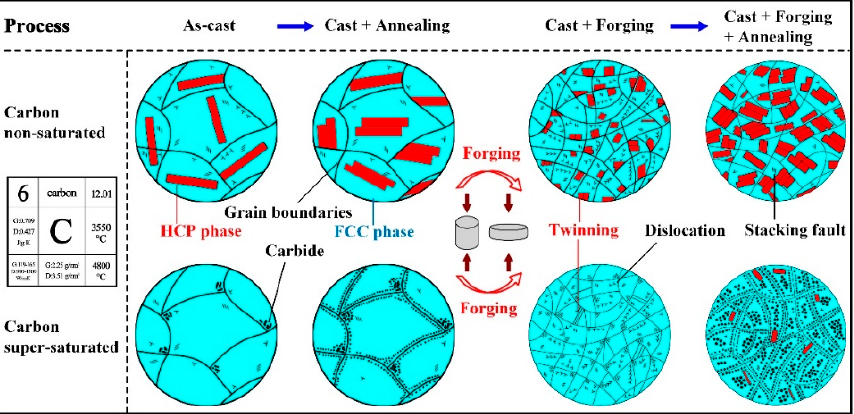
Figure 11. Schematic diagram of strengthening–toughening mechanism of the specimens with different carbon contents under different heat treatment states.